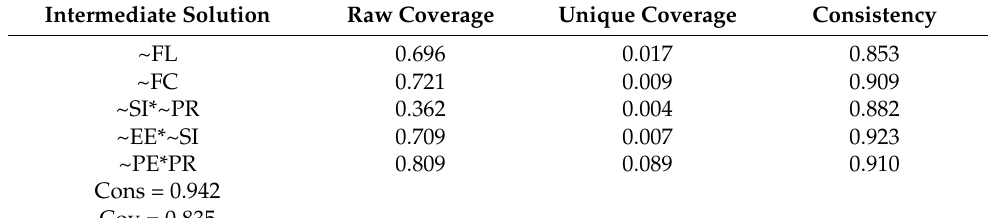
Table 5. QCA-IS and QCA-PS for the model ~IU = f(PE, EE, SI, FC, PR, FL). Intermediate